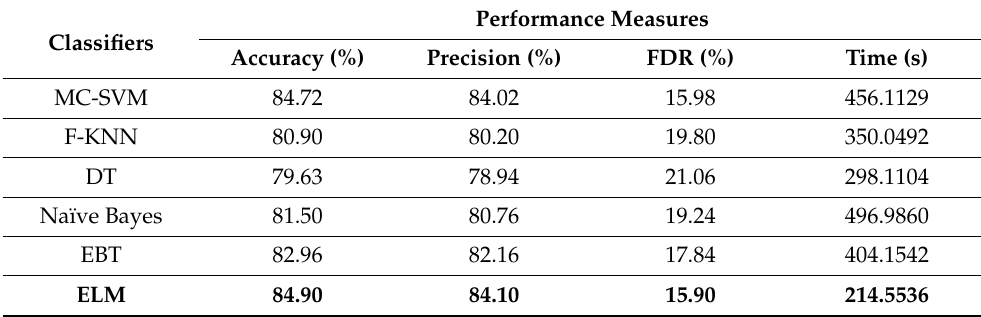
Table 1. Classification accuracy using originally extracted deep features for